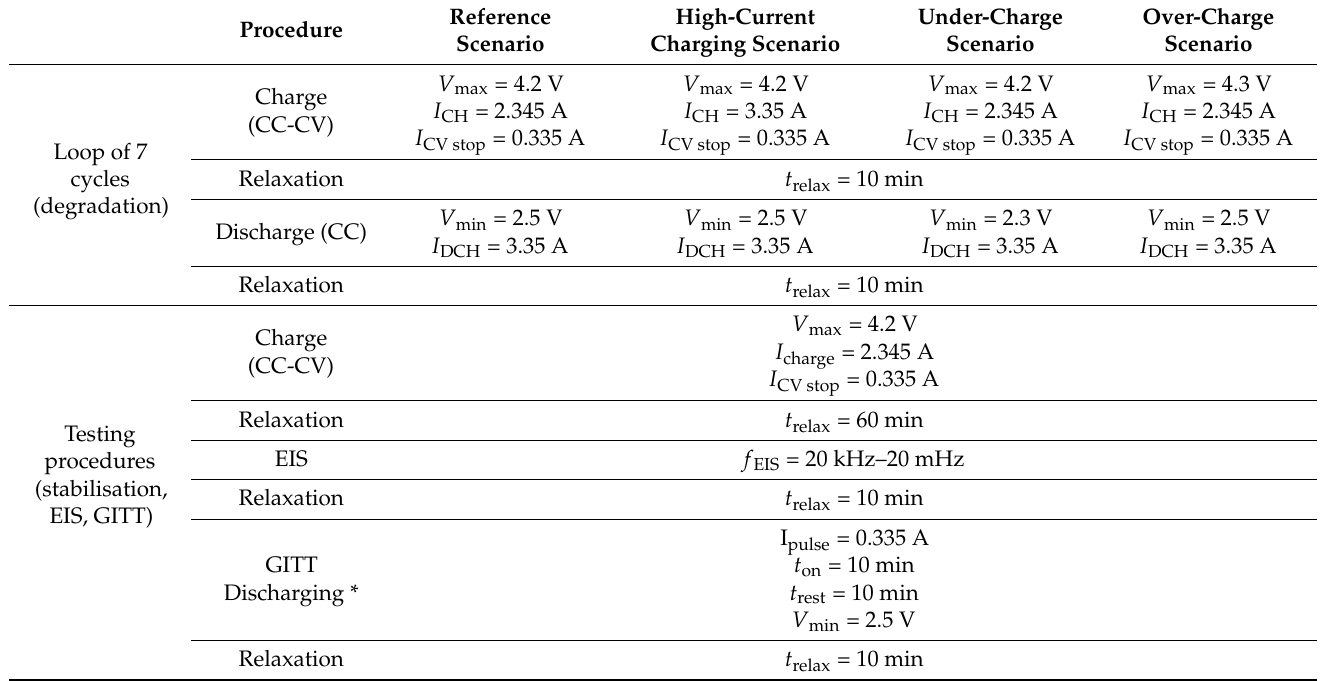
Table 2. Experiment protocols and settings of testing procedures for individual stress scenarios.